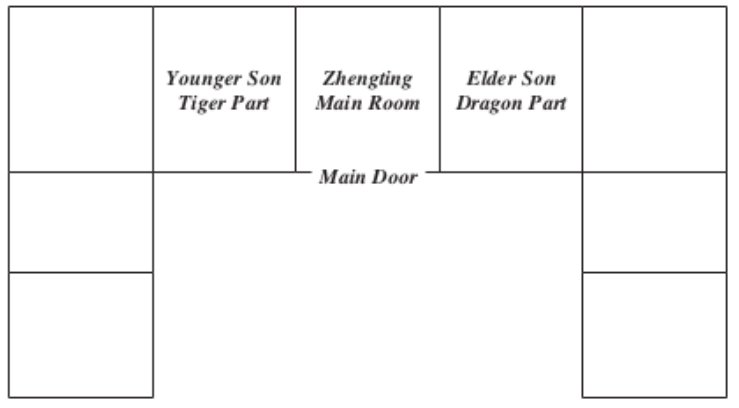
Figure 1. The traditional Taiwanese house, called Sanheyuan 三 合 院